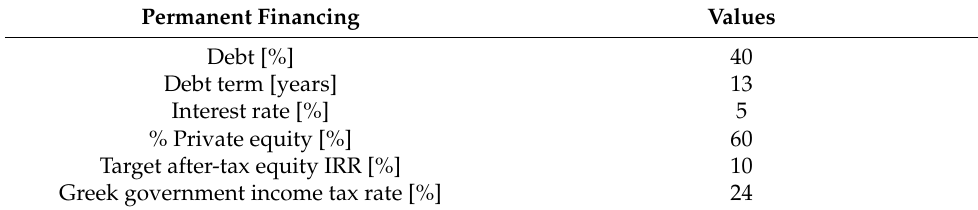
Table 6. Analysis of permanent financing of the investment.